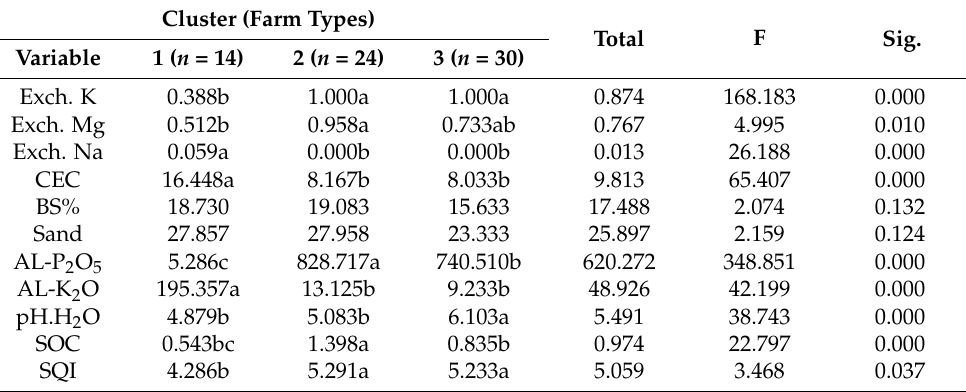
Table 7. Characterization of identified farm types based on p -value of one-way analysis of variance (equality of mean) of soil